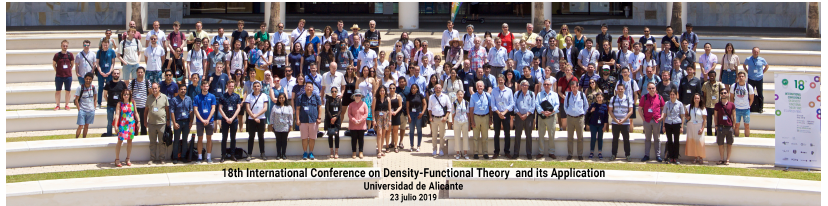
Figure 3. Group picture taken along the “18th International Conference on Density-Functional Theory and its Applications”, celebrated (2019) in the campus of the University of Alicante. Professor Karlheinz Schwarz is standing on the first row (11th starting from the right to the left